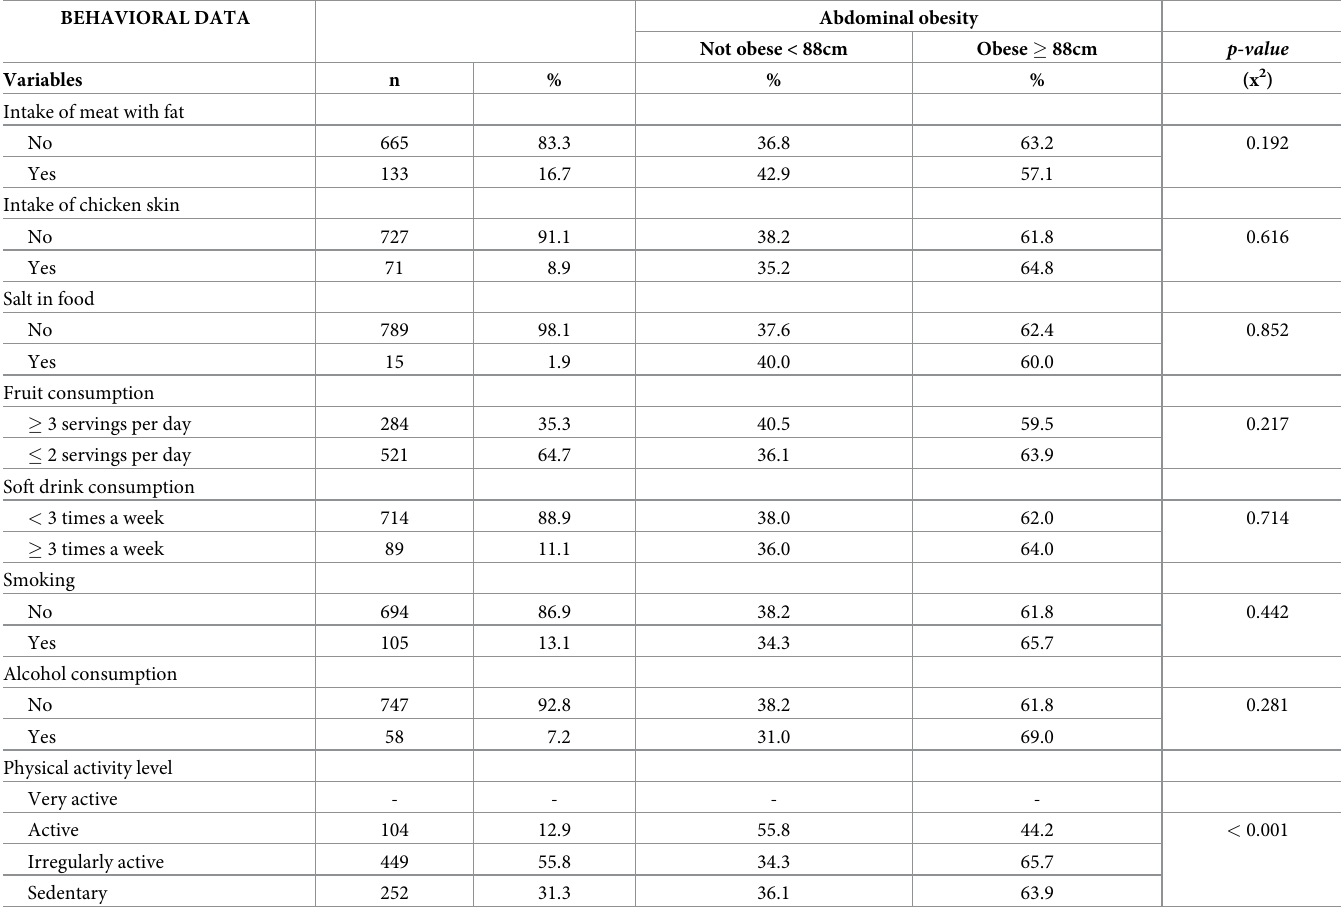
Table 2. Distribution of absolute and relative frequencies and bivariate analysis between abdominal obesity and behavioral variables in climacteric